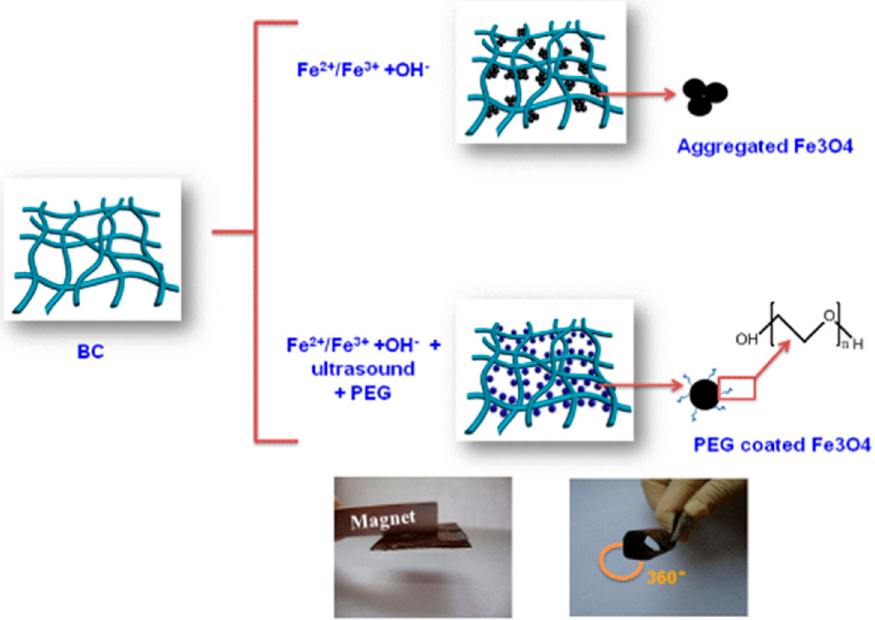
Figure 20. Schematic illustration for the Fe 3 O 4 –BC matrix process. Reprinted with permission from [225]. Copyright 2013 Elsevier.